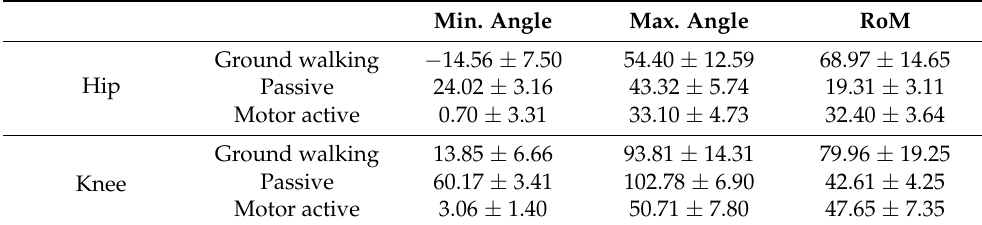
Table 3. Differences of lower limb angle according to gait